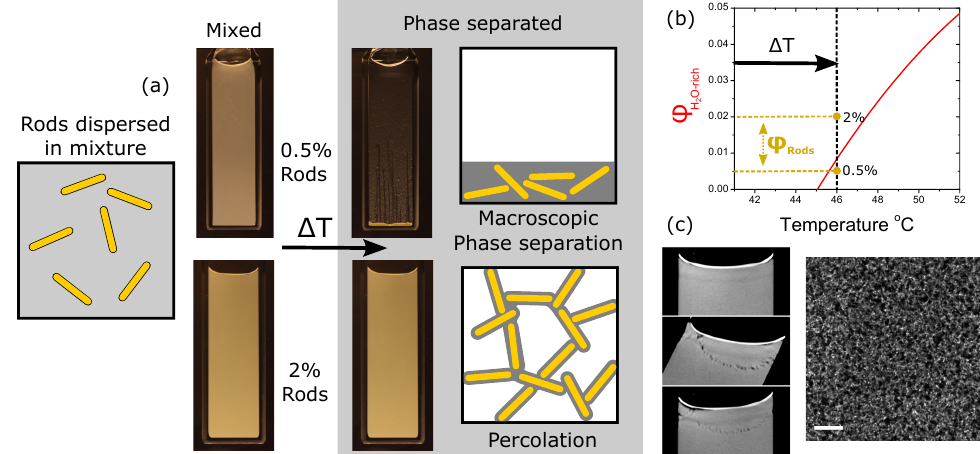
Figure 2. Showing how different concentrations of rods lead to radically different behaviour. ( a ) Images and cartoons of samples with rod volume fractions which are smaller and significantly larger than the volume of the minority phase; ( b ) The variation of the minority phase volume as a function of temperature compared to the volume of rods in the two cases of interest; ( c ) Image of a sample with 2% rods as it is tipped. There are indications that flow is resisted. The confocal micrograph shows the internal network formed by the rods, scale bar 50 µ